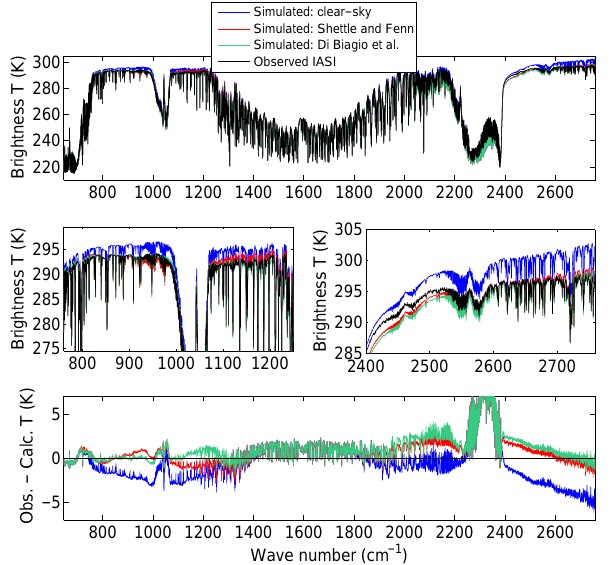
Figure 8. Top panel: IASI average spectrum (black) of the 12 soundings acquired on 22 June, compared to the average of the computed spectra: clear sky (blue), with dust aerosol, using Shet- tle and Fenn (1979) refractive indices (red), and Di Biagio et al. (2017) indices (green). Middle panels: close-up of the spectra in the IASI longwave (left) and shortwave (right) atmospheric windows. Bottom panel: residuals computed in the three